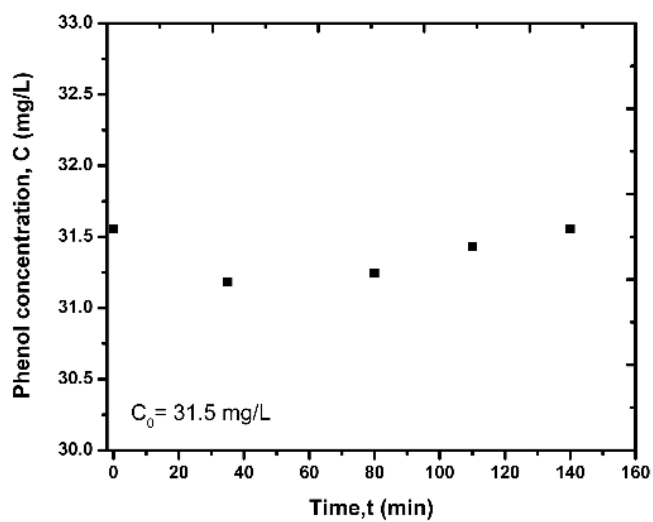
Figure 8. Transient response of phenol concentration during photolysis test.